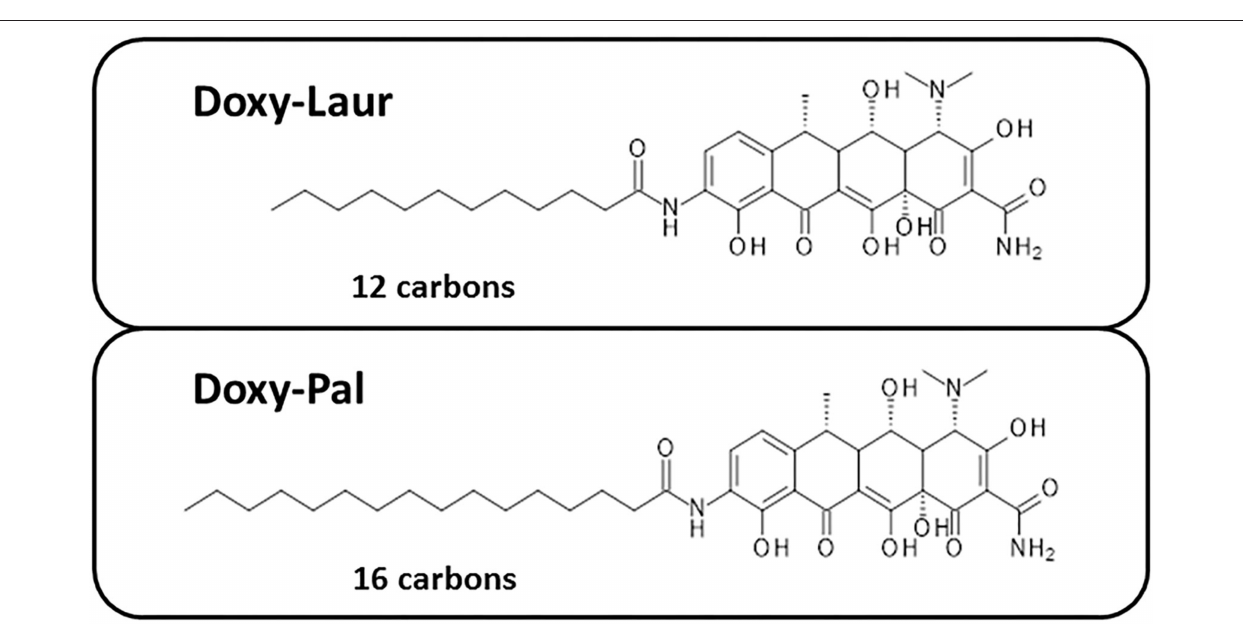
FIGURE 7 | Chemical structures of two other Doxycycline derivatives: Doxy-Laur and Doxy-Pal. We created two other new Doxycycline analogs by varying the chain length of the fatty acid attached to 9-amino-Doxycycline. These two analogs included Doxy-Laur (harboring a 12 carbon fatty acid) and Doxy-Pal (harboring a 16 carbon fatty acid). Their chemical structures are as